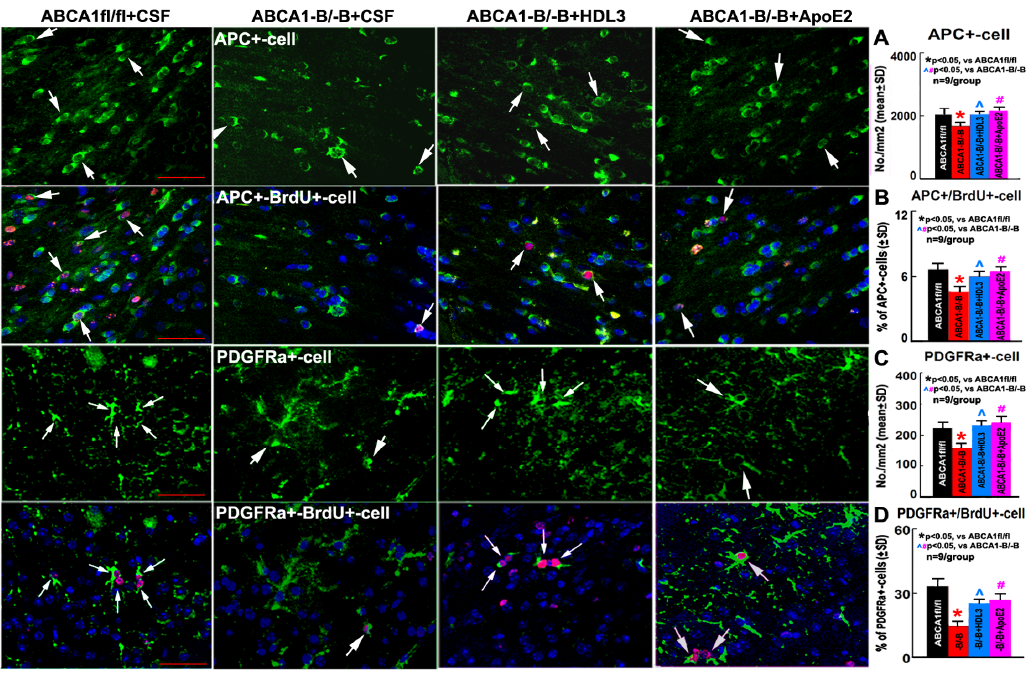
Figure 4. ABCA1 -B / -B vehicle stroke mice exhibit significantly increased oligodendrocyte (OL) loss and decreased oligodendrogenesis in the ischemic brain compared to ABCA1 fl / fl vehicle stroke mice; while treatment with HDL3 or ApoE2 reversed ABCA1 -B / -B induced the loss of OLs and oligodendrogenesis after stroke. ( A ) Adenomatous polyposis coli (APC + ) cells and the quantitative data in the CC of IBZ in the ipsilateral brains of ABCA1 fl / fl and ABCA1 -B / -B stroke mice. ( B ) APC + / BrdU + -cells and the quantitative data in the CC of IBZ in the ipsilateral brains of ABCA1 fl / fl and ABCA1 -B / -B stroke mice. ( C ) Platelet-derived growth factor receptor α (PDGFR α + ) cells and the quantitative data in the cortex of IBZ in the ipsilateral brain of ABCA1 fl / fl and ABCA1 -B / -B stroke mice. ( D ) PDGFR α + / BrdU + -cells and the quantitative data in the cortex of IBZ in the ipsilateral brain of ABCA1 fl / fl and ABCA1 -B / -B stroke mice. Scale bar = 50 µ m; * p < 0.05, vs ABCA1 fl / fl stroke mice, ˆ, # p < 0.05, vs. ABCA1 -B / -B stroke mice. n = 9 / group. Int. J. Mol. Sci. 2019 , 20 , x FOR PEER REVIEW